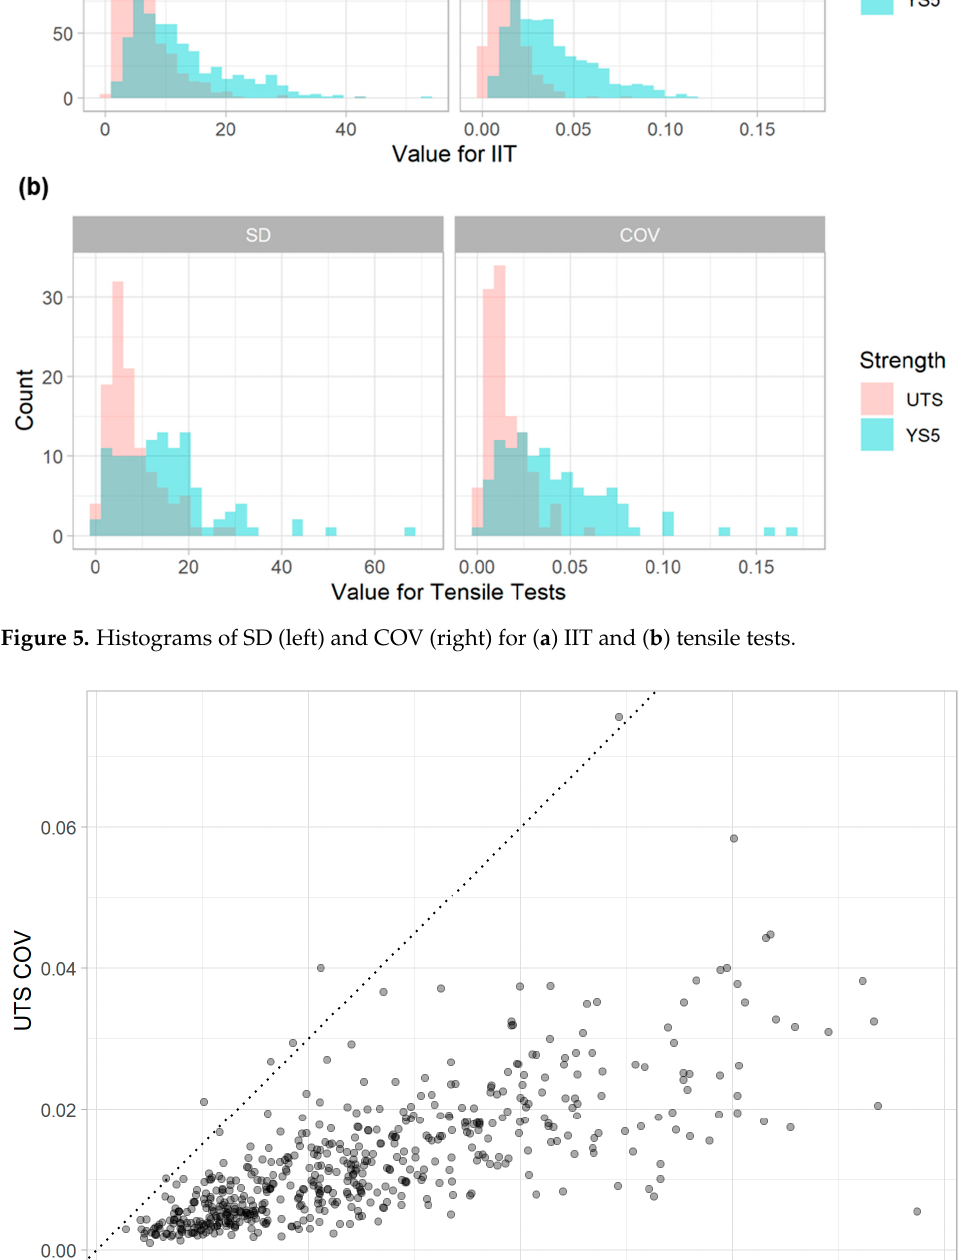
Figure 6. UTS COV vs. YS COV for IIT